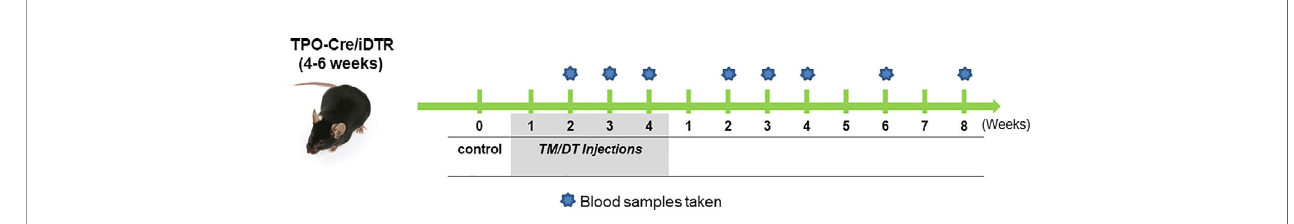
FIGURE 1 | The experimental protocol. TPO-Cre/iDTR mice aged 4 – 6 weeks received intraperitoneal injection of diphtheria toxin (0.1 ug/gm body weight) and tamoxifen (1 mg/100 ul/mouse) every other day in weeks 1 – 4 as illustrated. Blood samples were collected at the indicated time points during the injection period and after stopping the injections. Samples were then subjected to TSH and total T4 in serum assays, their thyroids were collected from randomly chosen mice for histology and also for total thyroid RNA preparation for